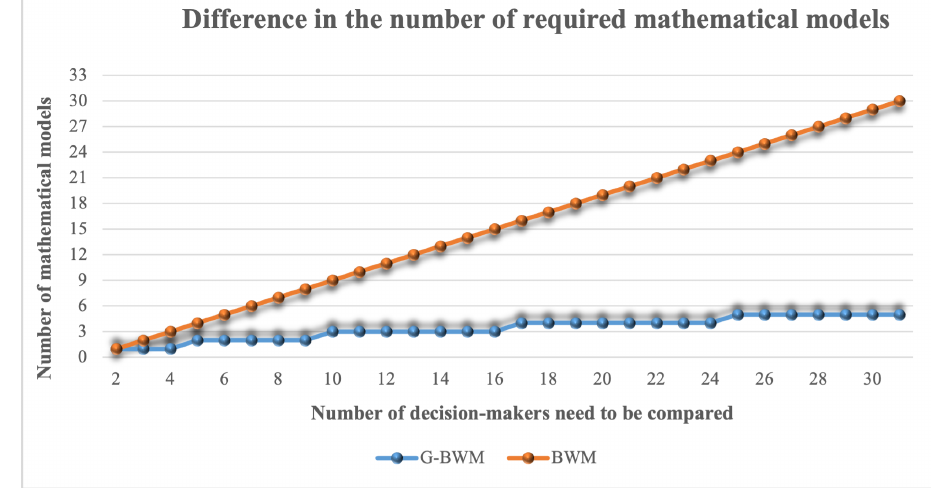
Figure 8. Differences in the number of required mathematical